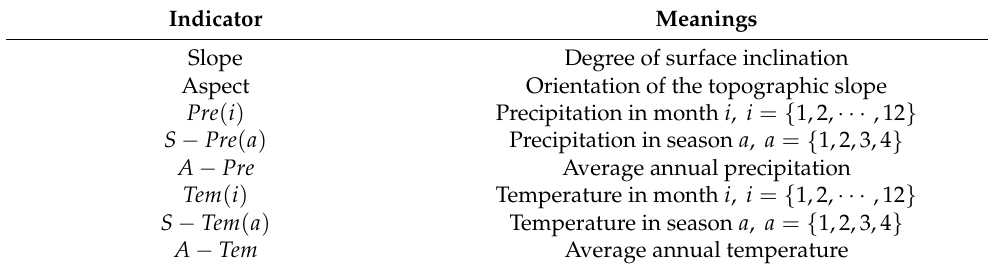
Table 3. Environmental indexes and